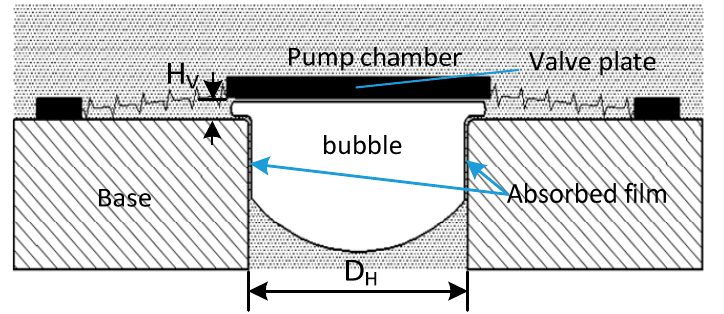
Figure 4. Bubble through valve plate.